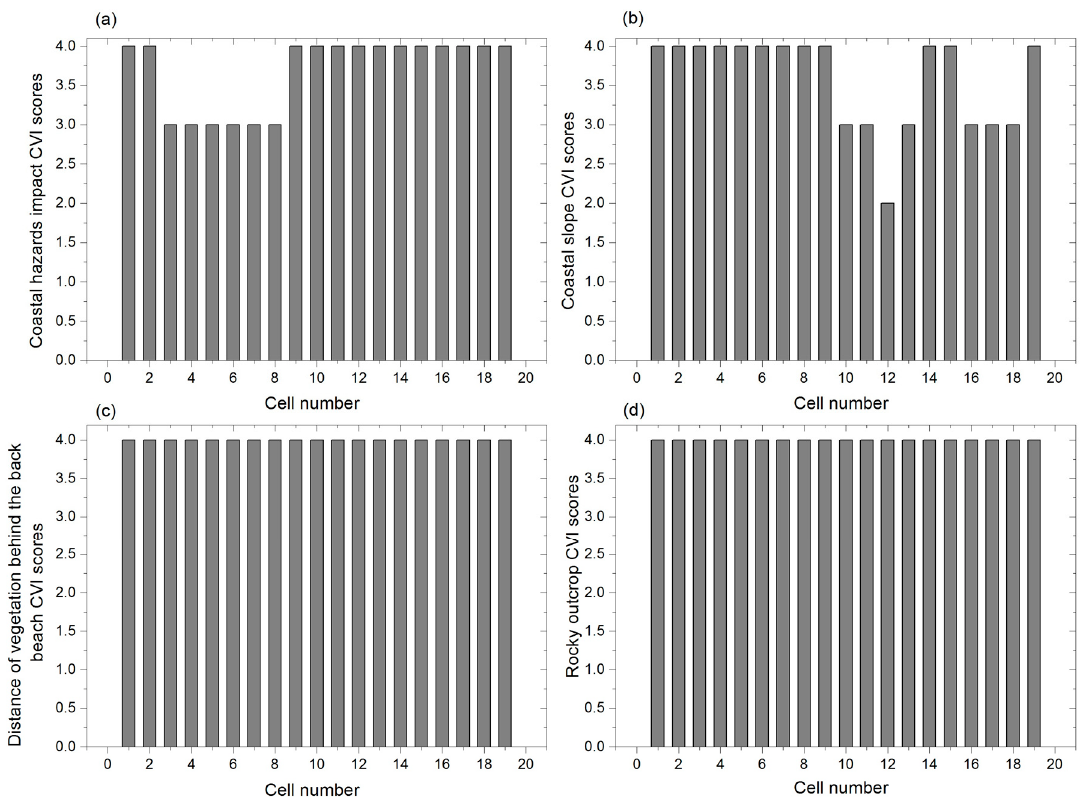
Figure 5. Distribution of overall Micro Town Coastal Vulnerability Index (MTCVI) scores. ( a ) Coastal landslides impact ; ( b ) Coastal slope; ( c ) Distance of vegetation ; ( d ) Rocky outcrop.